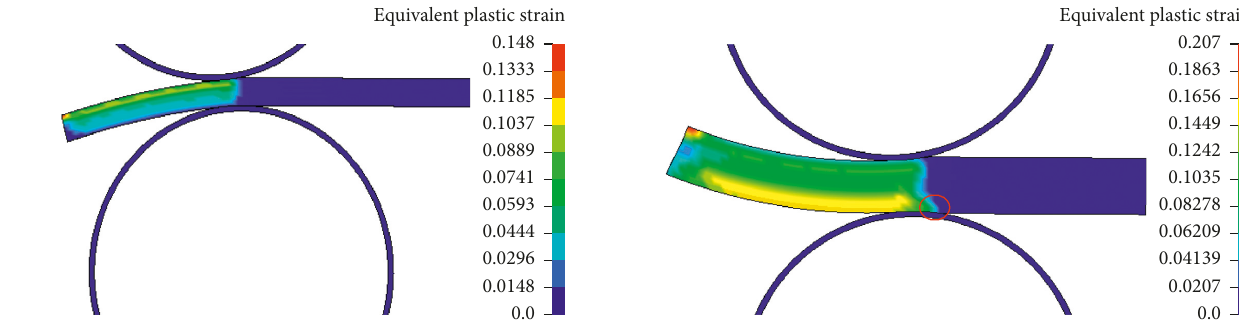
Figure 7: Distribution of equivalent plastic strain inside the plate with speed ratio being